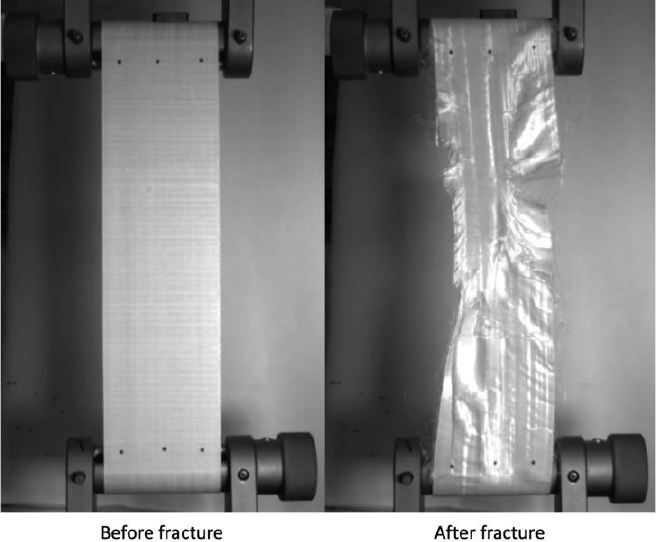
Figure 4. Images of a sample specimen before and after mechanical testing.